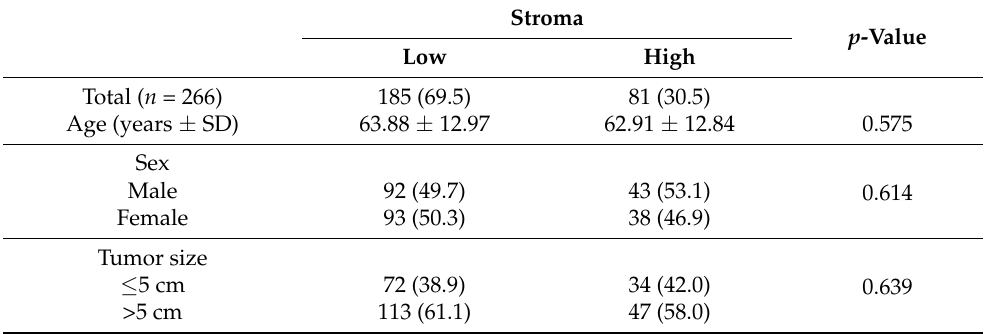
Figure 1. Representative images are showing colorectal cancers with various tumor–stroma ratios ( A – D ). ( A ) Colorectal cancer with stroma-low (×200). ( B ) Colorectal cancer with stroma-high (×200). ( C ) Colorectal cancer with the mucinous component (×200). ( D ) Colorectal cancer with a micropapillary component (×200). (Scale bar = 100 μ m). Table 1. The correlation between the tumor–stroma ratio and clinicopathological parameters in colorectal cancers.